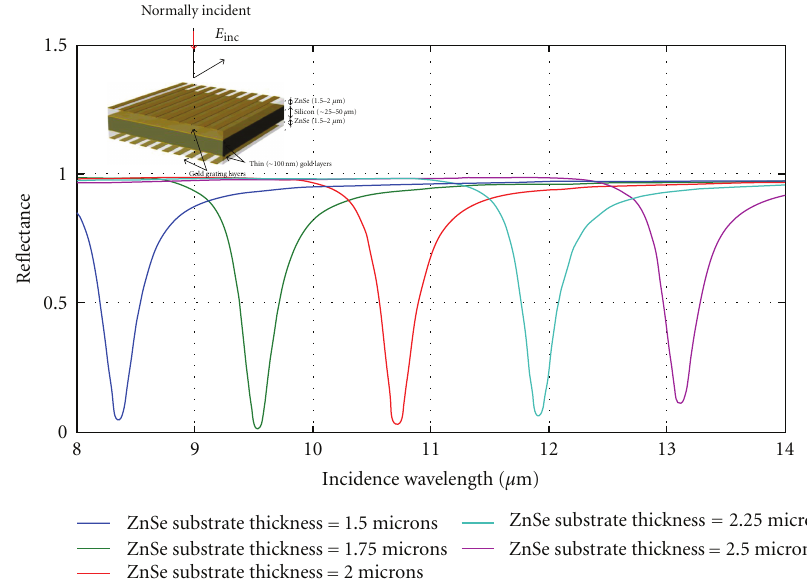
Figure 4: Simulation results, using the RCW method, that present the reflectance at normal incidence within the LWIR band as the ZnSe substrate thickness is varied from 1.5 to 2.5 µ m. For this simulation, the grating period is fixed at 3.0 µ m with a 50% duty cycle. The incident wave was normally incident with parallel polarization. As the substrate thickness is increased, the resonant absorption peak shifts to longer wavelengths but still remains strong. The bandwidth of the resonance also remains relatively fixed as the substrate thicknesses is varied.